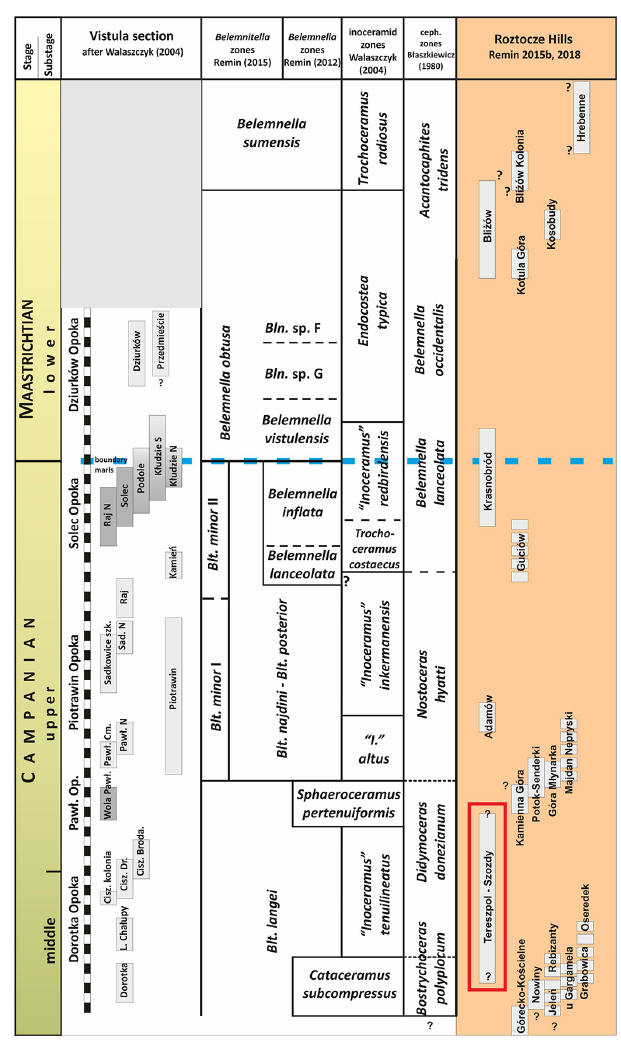
Figure 4. The stratigraphic position of the Szozdy section (right col- umn; scale not included relative to the Middle Vistula River com- posite section (left column; scale bar = 2m). A full description of the other sections of the Roztocze Hills and their stratigraphic posi- tion will be provided elsewhere. The biostratigraphic subdivision follows Błaszkiewicz (1980), Walaszczyk (2004), Remin (2012, 2015), Remin et al. (2015b), and Remin